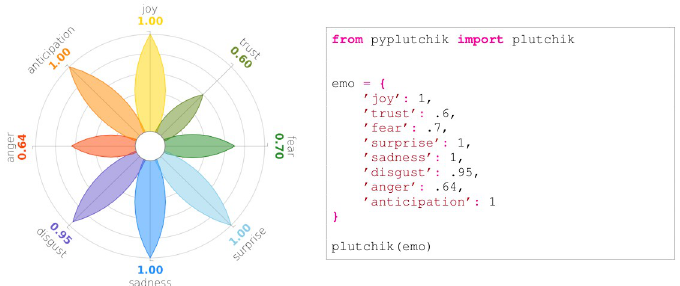
Fig 4. Plutchik’s wheel generated by code on the right. Each entry in the Python dict is a numeric value 2 [0, 1].